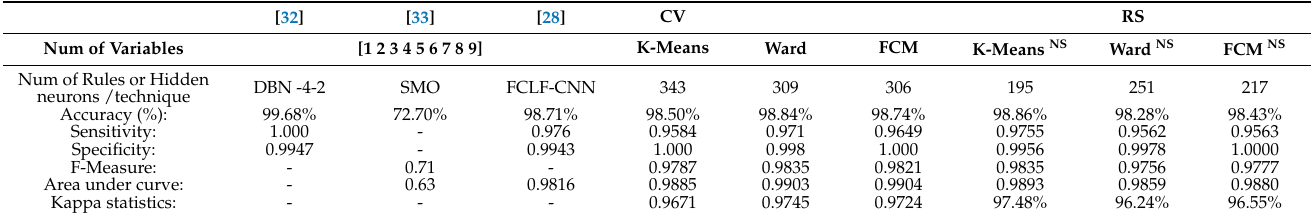
Table 8. Performance metrics obtained with our proposed framework compared with results obtained by other authors obtained from the